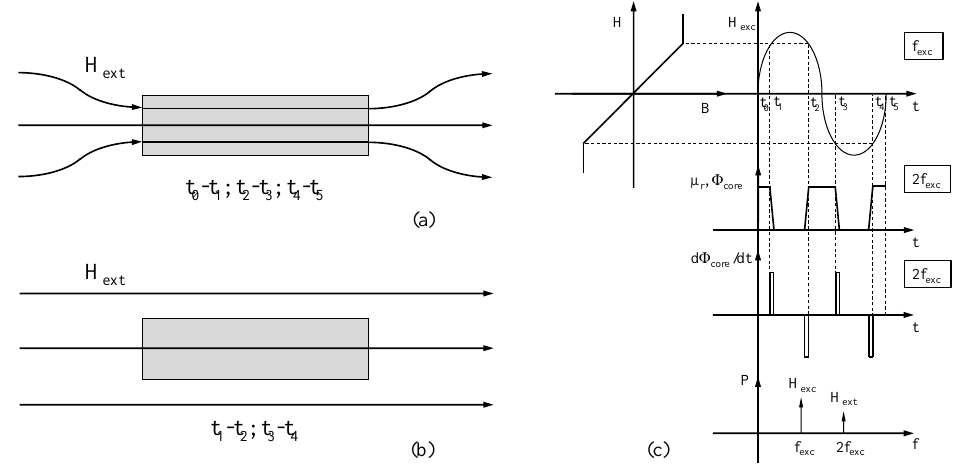
Figure 1. Scheme of the basic fluxgate working principle. ( a ) The core is not saturated, and the magnetic flux is concentrated inside. ( b ) The flux is “gated” out when the permeability drops to µ 0 . ( c ) Time evolution of the main quantities in a period of the excitation field H exc